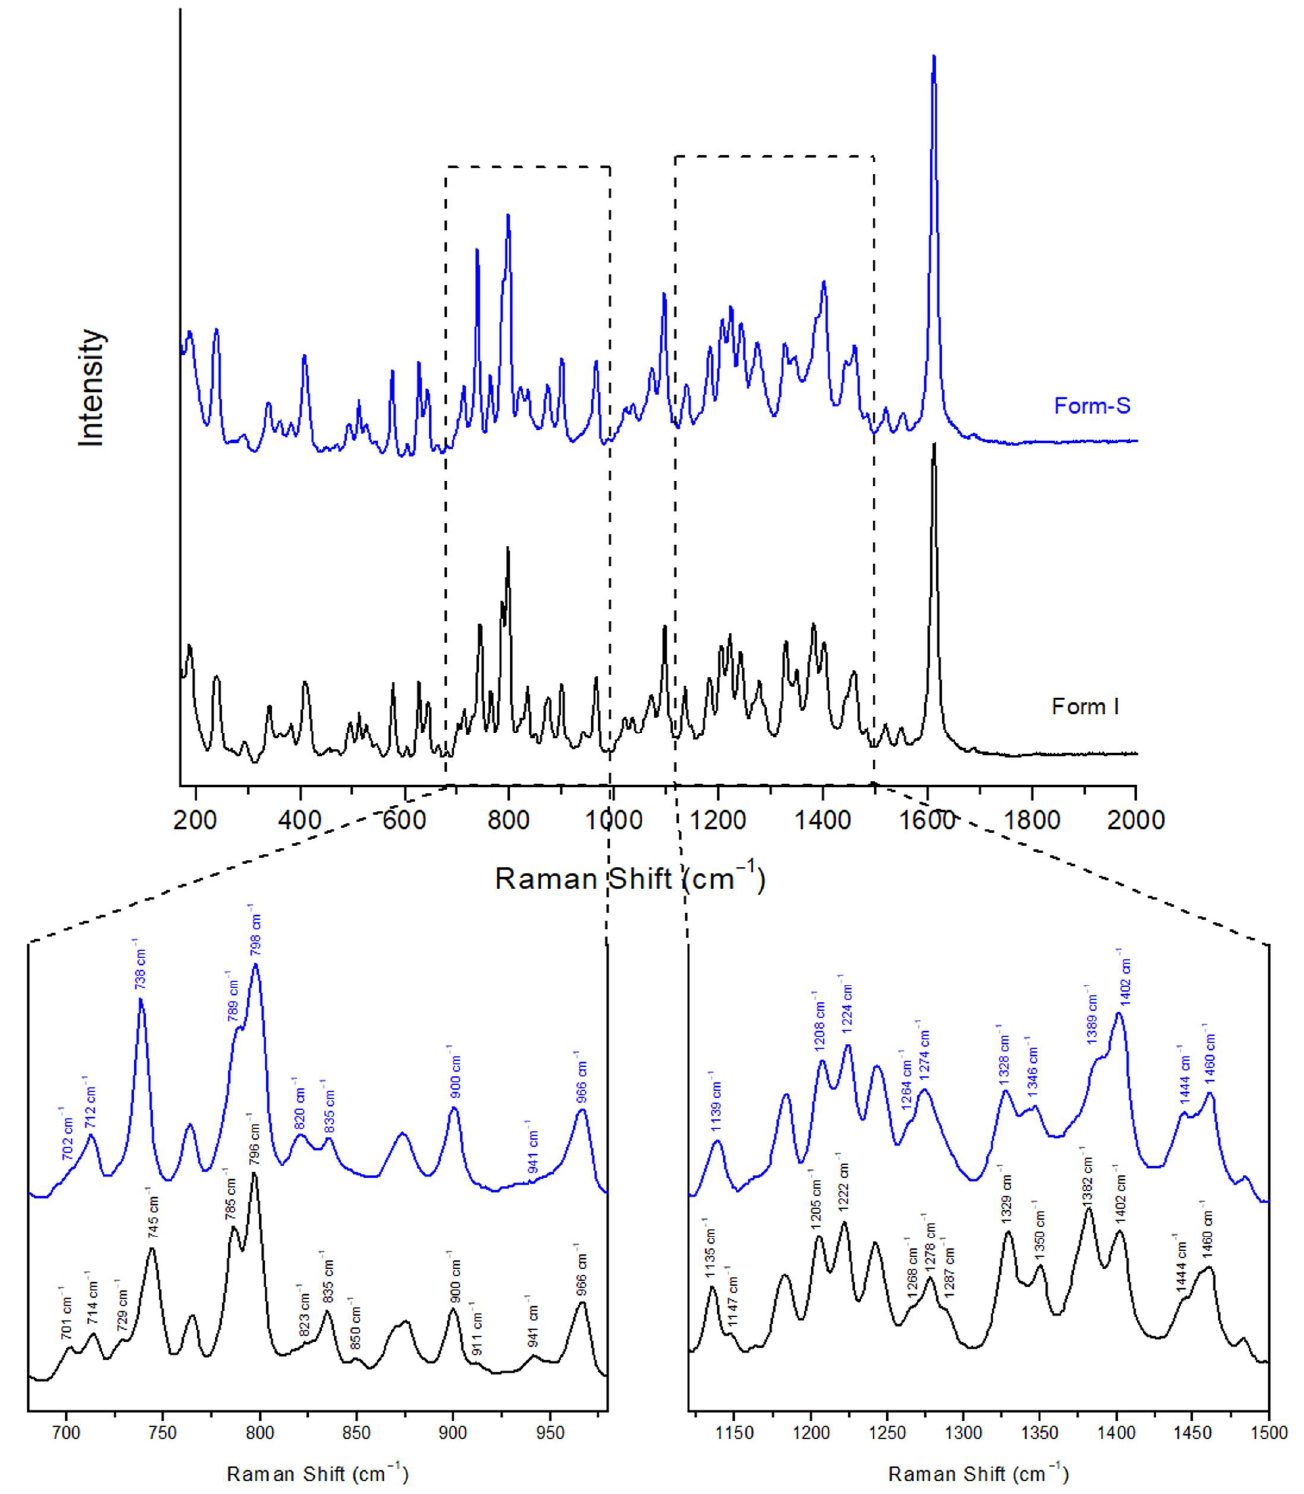
Figure 4. Raman spectra of posaconazole Form I and posaconazole Form-S. Inset: magnification of spectral areas 680–980 cm −1 and 1120–1500 cm −1 (black peak labels: characteristic peaks for posaconazole Form I; blue peak labels: characteristic peaks for posaconazole Form-S).